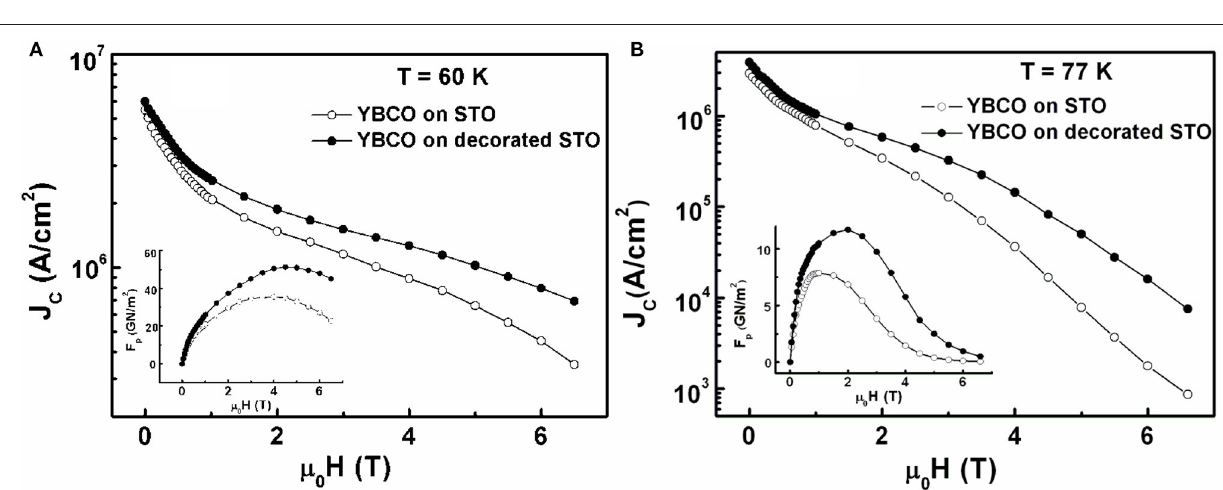
FIGURE 18 | Variation of critical current density with applied magnetic field as measured at (A) 60K and (B) 77K for YBCO films on the undecorated and LSMO decorated STO substrates. Variation of the corresponding pinning force density with applied magnetic field is shown in the insets of (A,B) . Reproduced from Jha et al. [165], with the permission from AIP